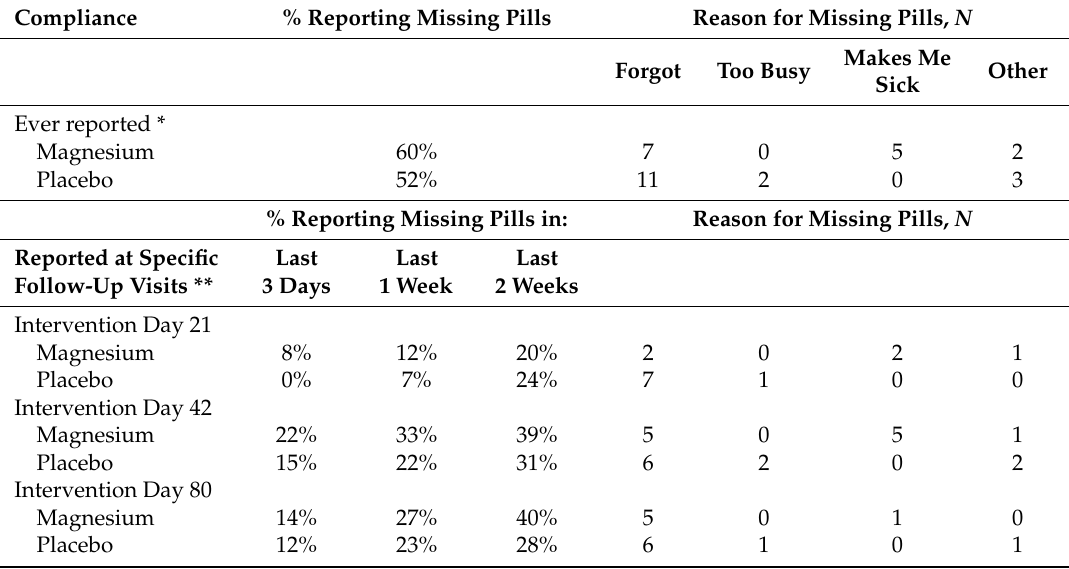
Table 2. Self-reported